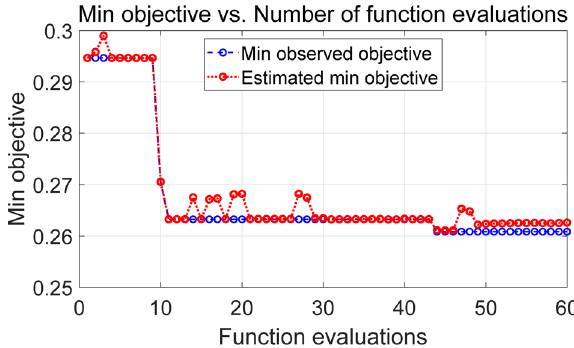
Fig. 1 Bayesian optimization loss of decision tree over function evaluations. Blue line represents the minimum observed objective and red line represents the estimated minimum